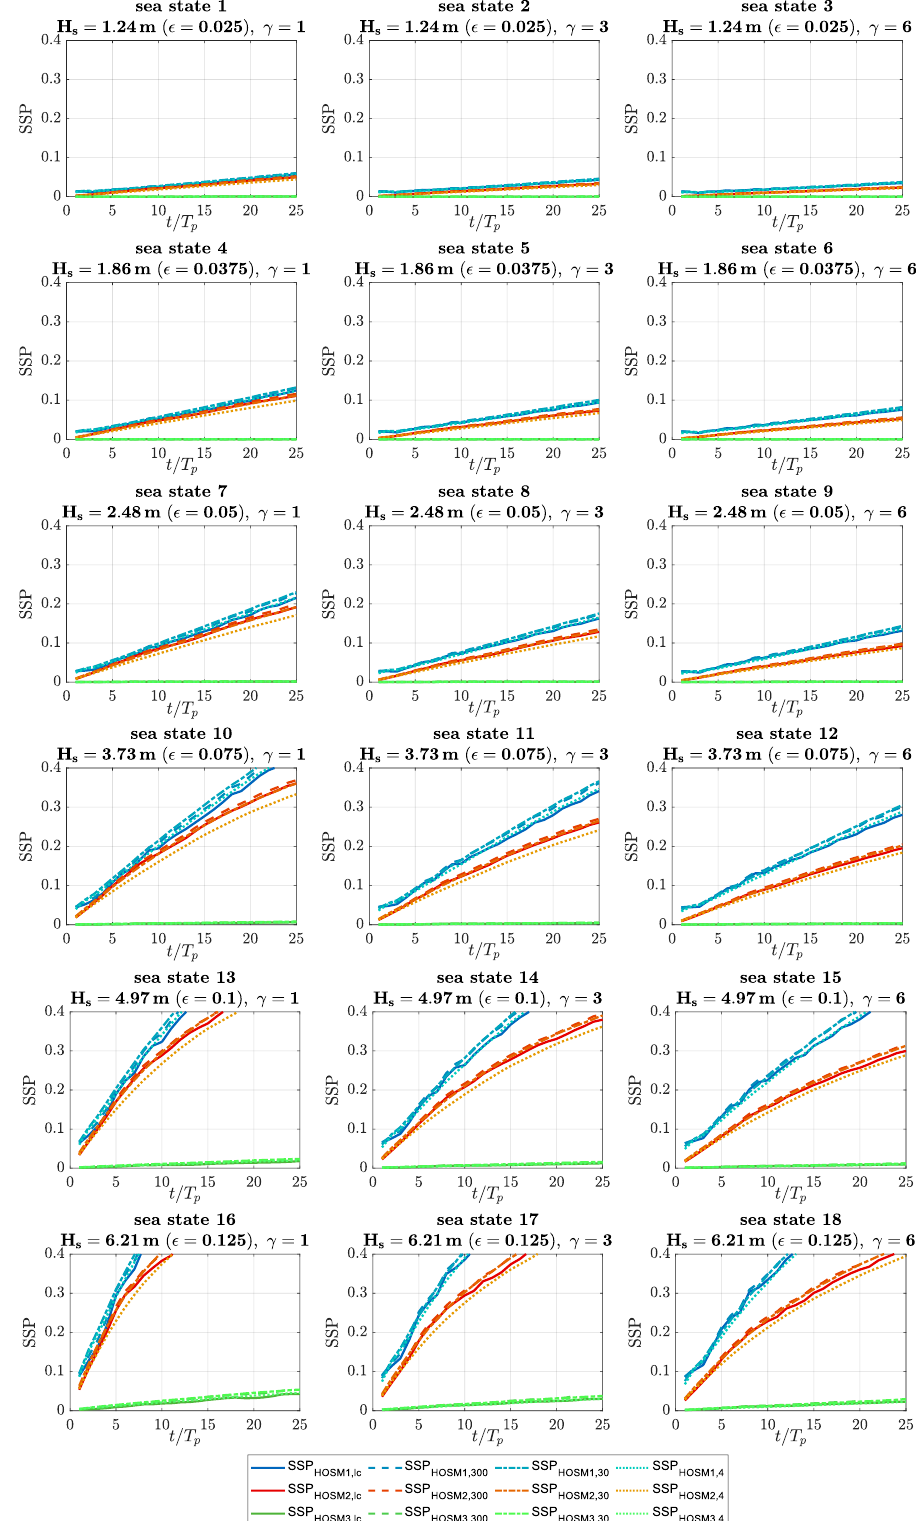
Figure 2. Numerical results: SSP for the investigated sea states (Table 1) for HOSM1 (blue), HOSM2 (red), and HOSM3 (green) with long-crested waves (solid lines) and short-crested waves with spreading factors 300 (dashed lines), 30 (dashed-dotted lines), and 4 (dotted